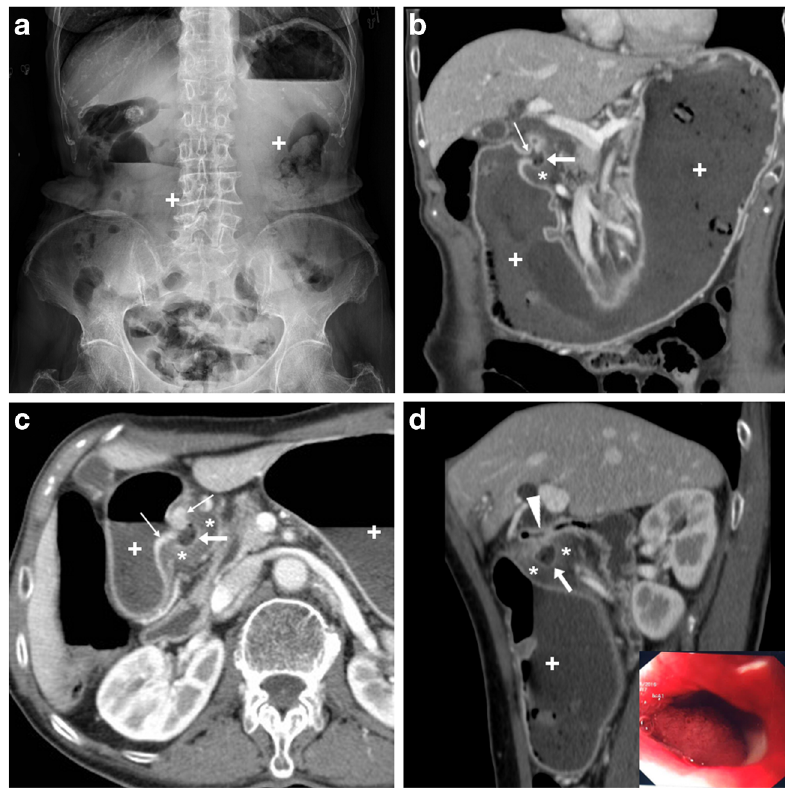
interrupted at the site of an ulcer crater (arrows). Endoscopy confirmed moderate stricture of the proximal duodenum and post-pyloric ulcer (image in inset d ) with fibrinous base, hyperaemic periphery, slightly irregular mucosal surface; biopsy excluded neoplastic changes. After PPI and anti-HP therapy, the patient ultimately required surgical treatment with duodenotomy, antrectomy and Roux-en-Y gastrojejunostomy [Adapted from Open Access ref. no